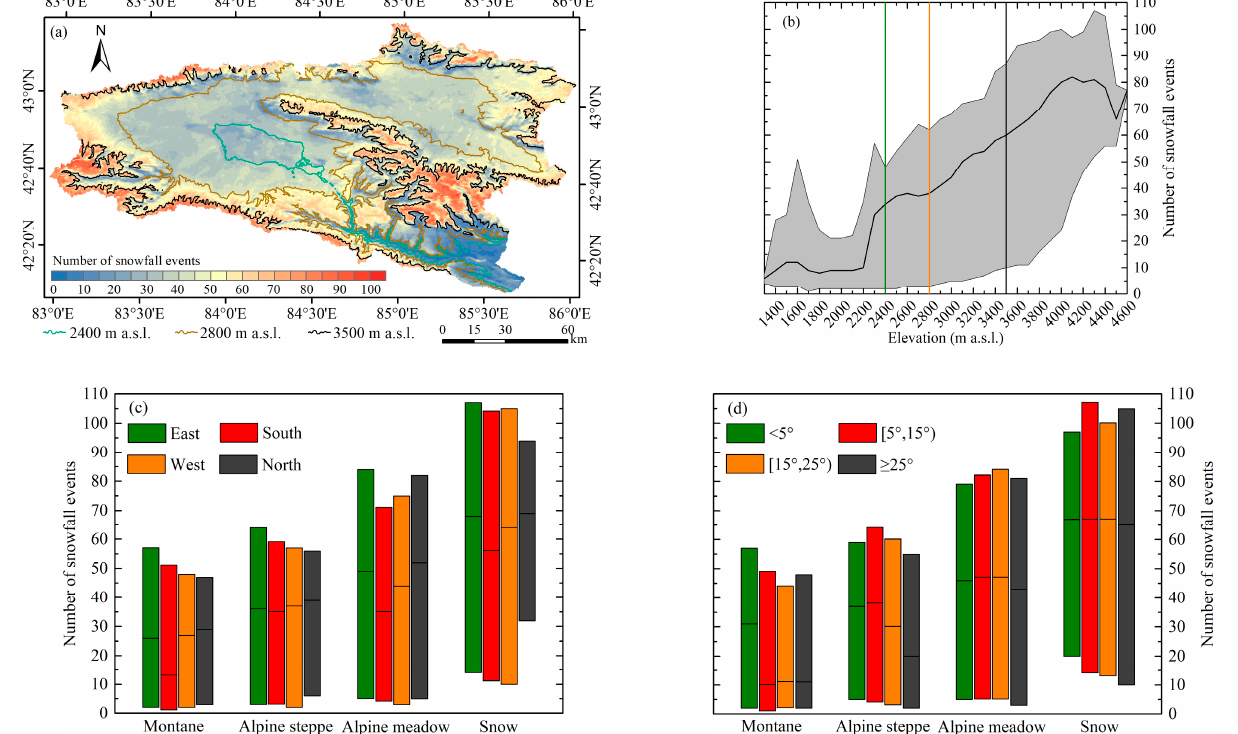
Figure 7. ( a ) Spatial distribution of the mean frequency of snowfall from June 2000 to May 2020 over the KRB; ( b ) the minimum, mean, and maximum frequency of snowfall events with an elevation over the KRB during 20 hydrological years; ( c ) the minimum, the mean, and maximum frequency of snowfall with aspect in four elevation zones over the KRB during 20 hydrological years; and ( d ) the minimum, the mean, and maximum frequency of snowfall with slope angle in four elevation zones over the KRB during 20 hydrological years.